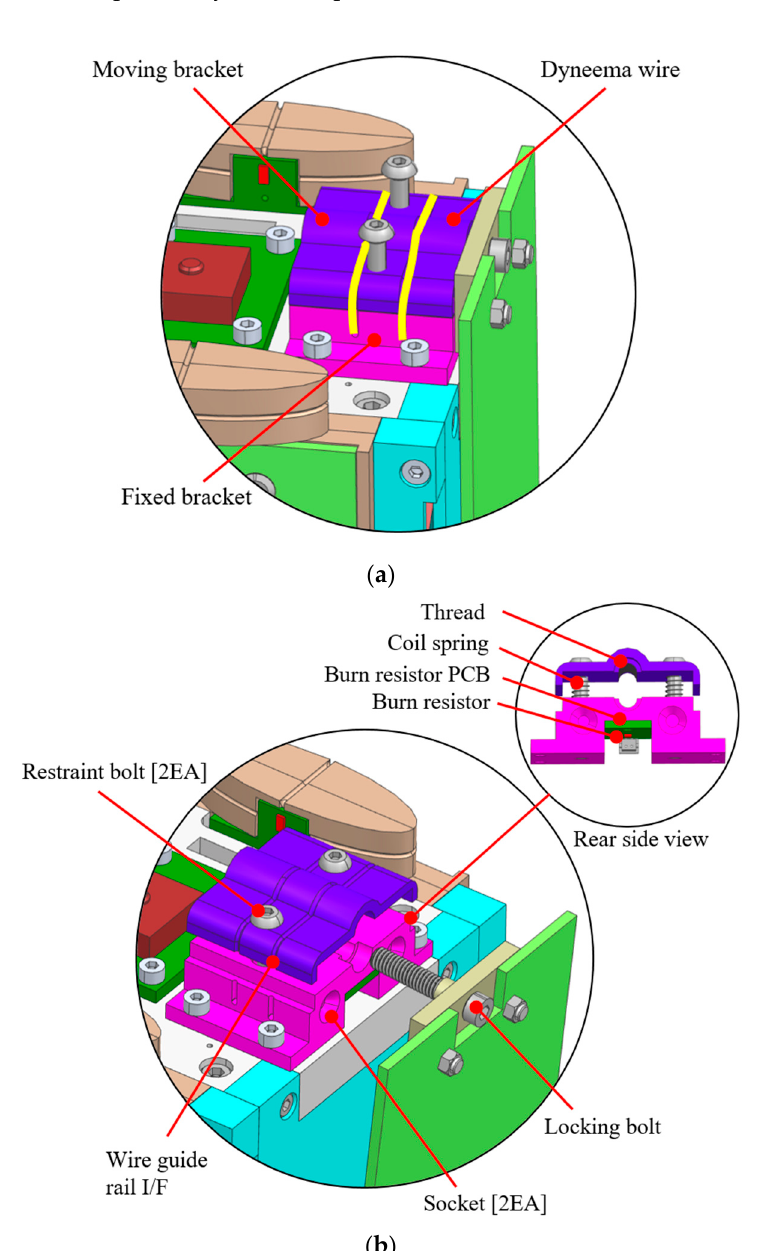
Figure 5. Close-up views of the separation nut-type HRM for the ( a ) fully stowed and ( b ) partially deployed solar panels.